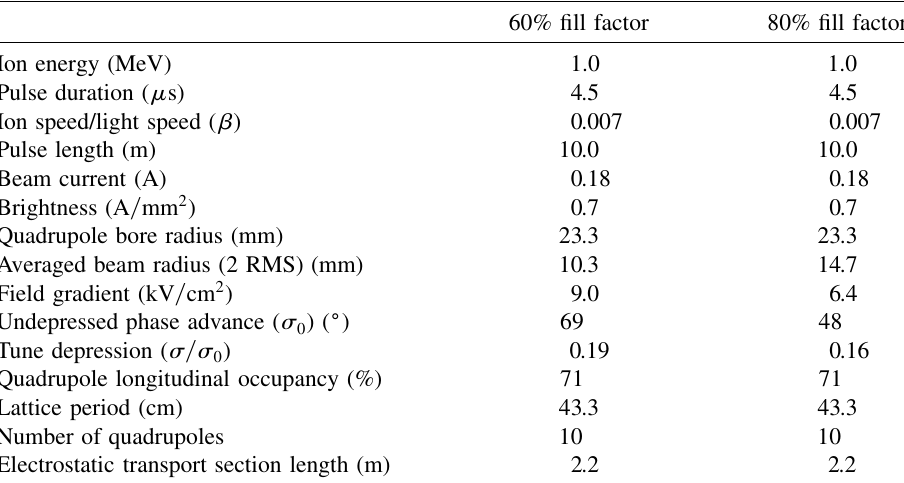
TABLE I. Main beam and lattice parameters in the electrostatic transport section.